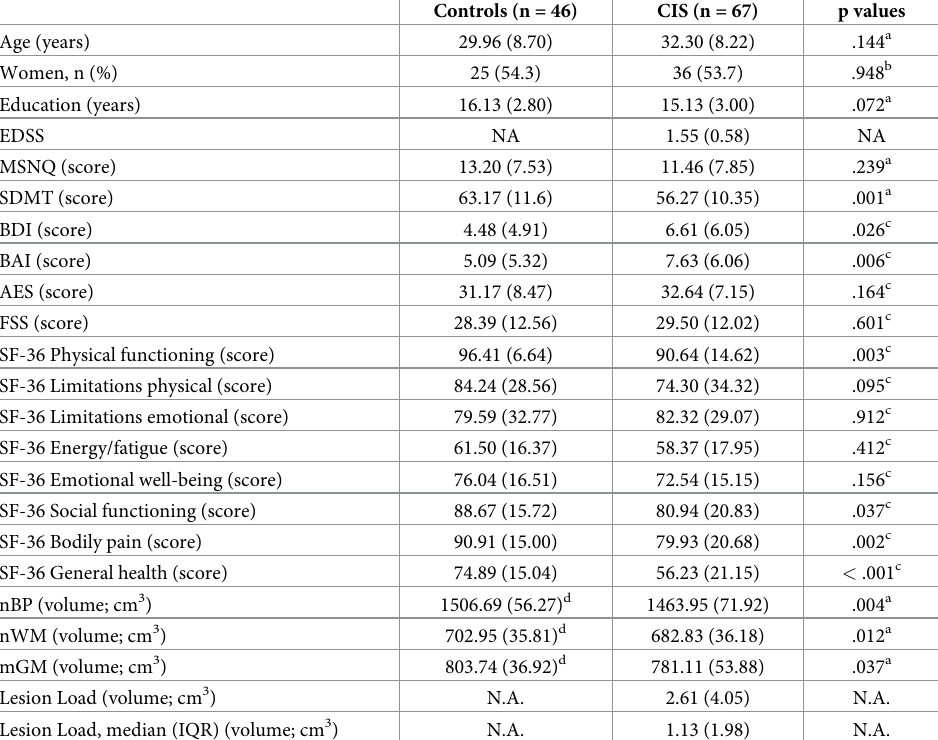
Table 1. Characteristics of the study